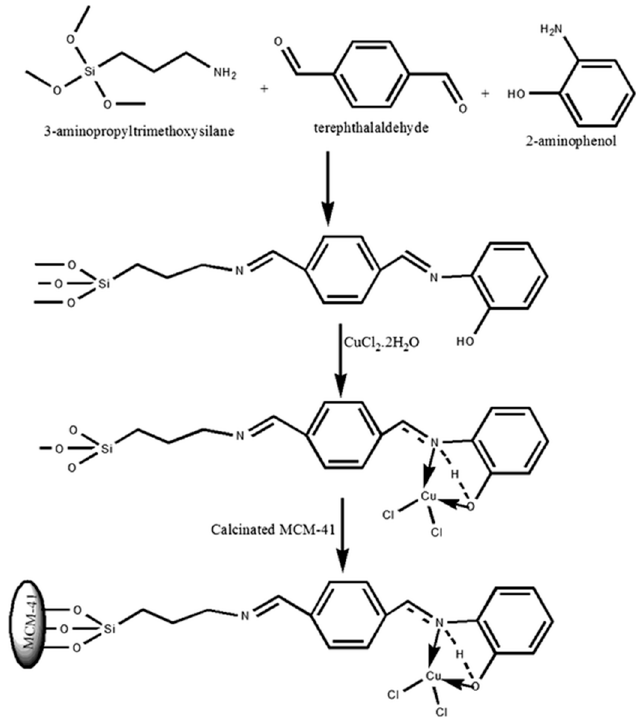
Figure 28. Synthesis of Cu- Schiff base MCM-41 complex. Reproduced with permission from [36]. Copyright 2016 Springer.